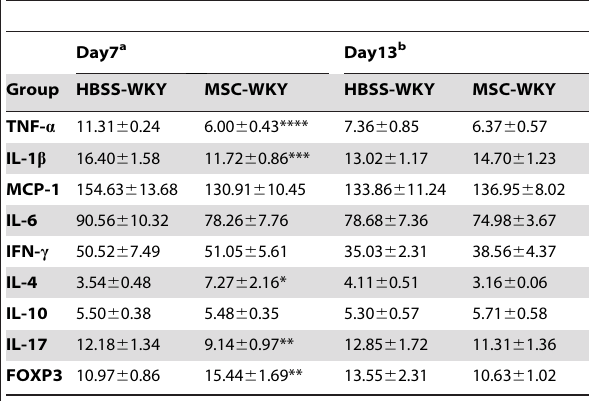
Table 3. Results of real-time RT-PCR for cytokine genes in renal cortex.